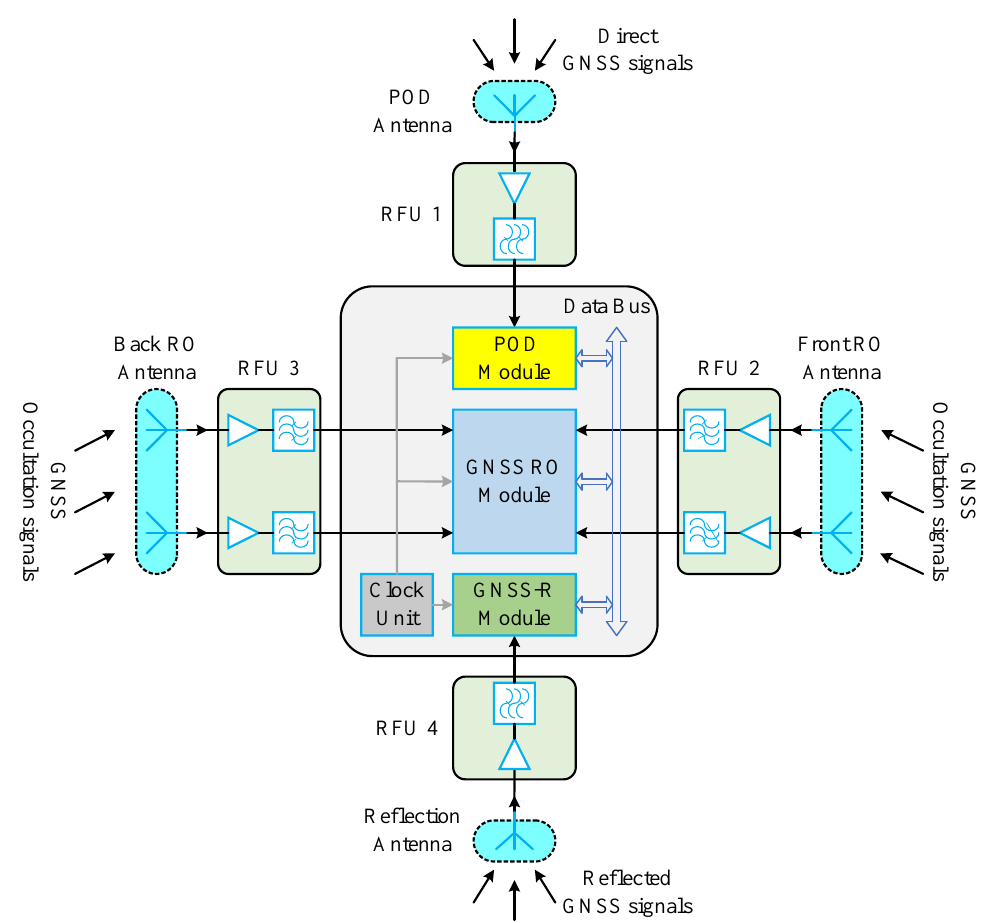
Figure 2. The structure of the SIGRS. The module in yellow (top) is the POD module which provides position and timing information for the other two remote sensing modules and the satellite platform. The module in blue (middle) is the GNSS RO module which provides information about the ionosphere and neutral atmosphere. The module in green (bottom) is the GNSS-R module which provides information about ocean, ice, and land. The module in gray (bottom) is the clock unit which generates synchronous clock signals for POD, GNSS RO, and GNSS-R modules.